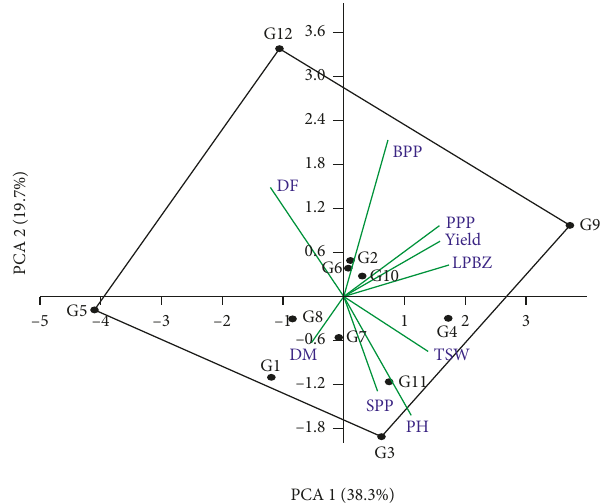
Figure 3: Principal component analysis scatter diagram of sesame genotypes and their agronomic traits (genotype codes and agro- nomic traits are as designated in Tables 2 and 3,